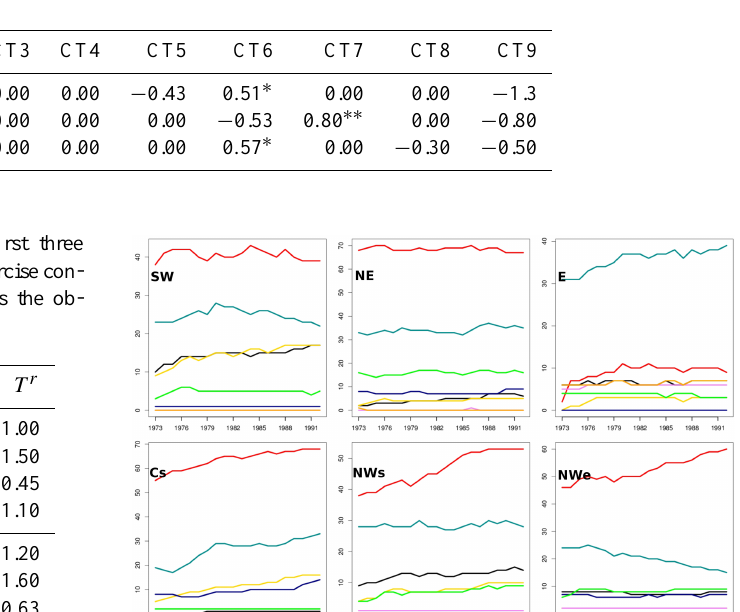
Table 9. Trends in the frequency of CTs for the different CT classifications. One (two) asterisk indicates trends at 90% (95%) of the confidence level (Mann–Kendall test).